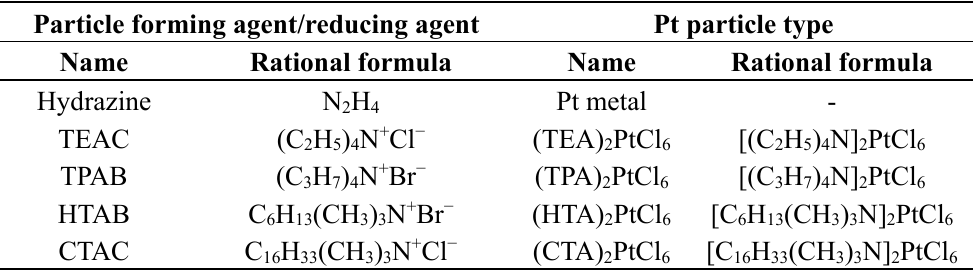
Table 1. Complex-forming agent/reducing agent and type of Pt particles